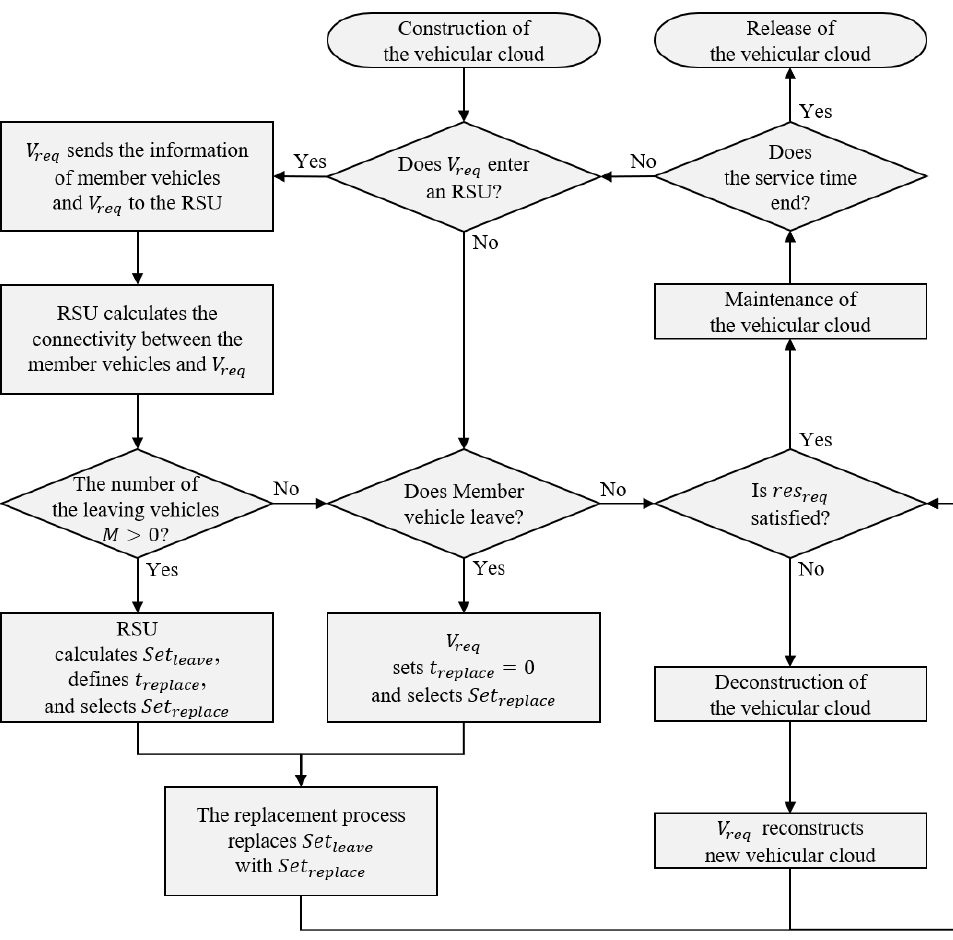
Figure 2. The common flow chart of the proposed